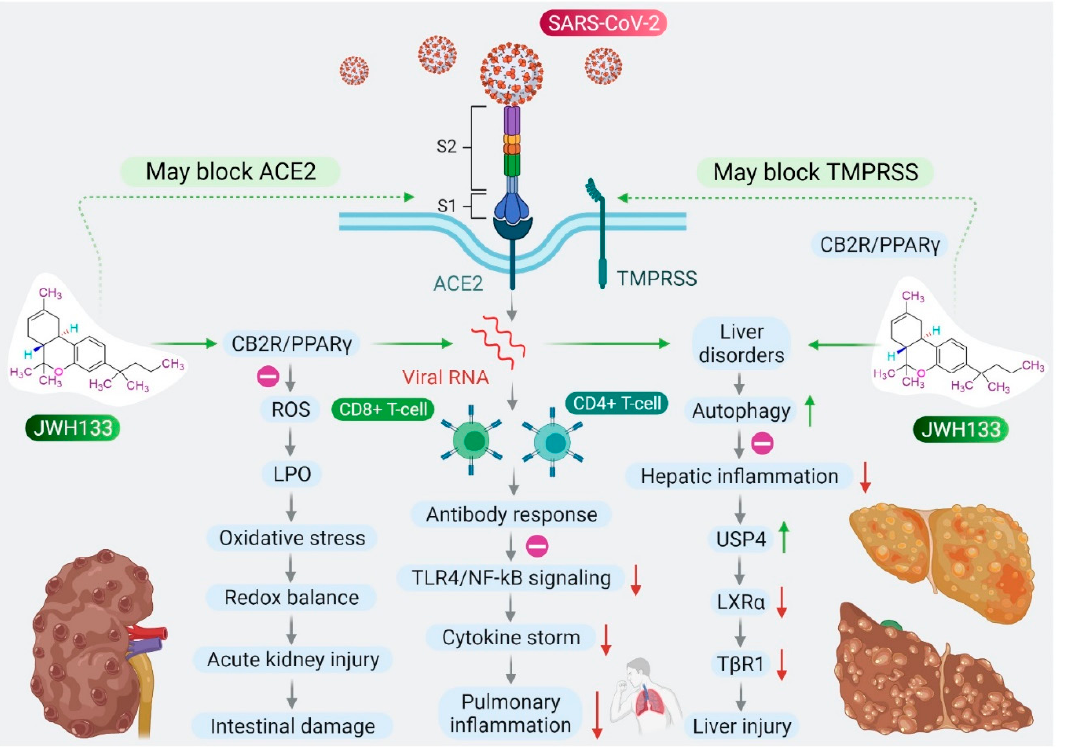
Figure 2. Proposed scheme of potential and mechanisms of JWH133 on immunity, infection, and inflammation against SARS-CoV-2.